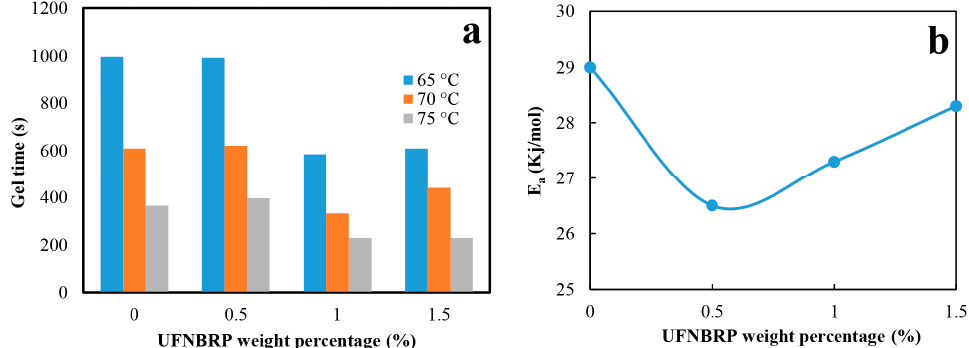
Figure 6. ( a ) Gel time diagram for the epoxy resin and epoxy resin/UFNBRP nanocomposites and ( b ) activation energy diagram of neat epoxy resin at different elastomeric nanoparticles concentra- tions.